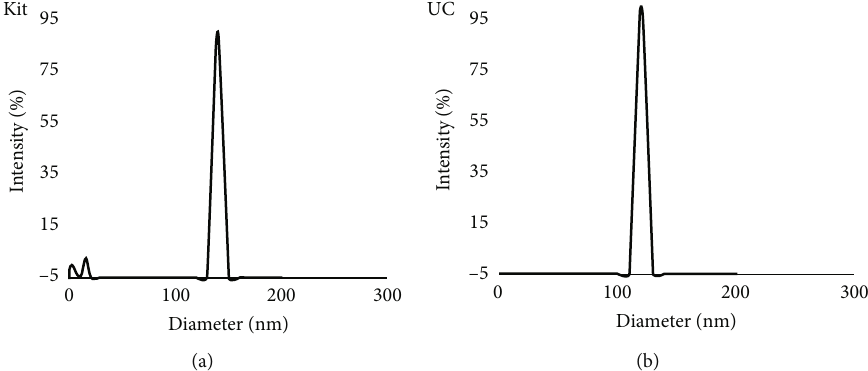
Figure 2: Zetasizer graph showing the size distribution by intensity. One prominent peak ( 149 : 9 ± 15 : 17 nm ) and two small peaks (15.2 nm and 5.1 nm) were observed with samples derived using the kit ( n = 3 ) (a). A single peak ( 124 : 43 ± 9 : 90 nm ) was observed with samples derived using UC ( n = 3 )